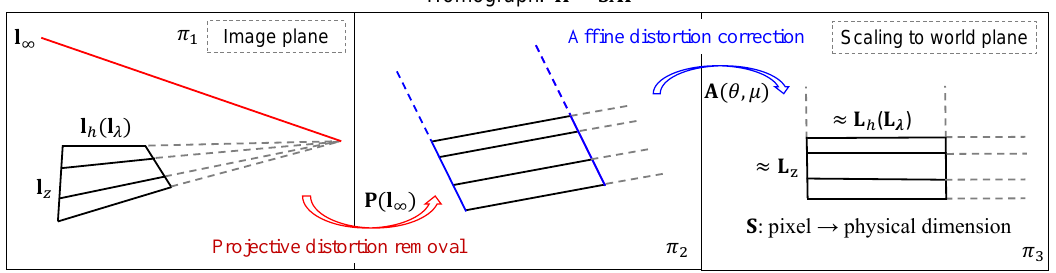
Figure 4. Image rectification: from projective distortion removal to affine distortion